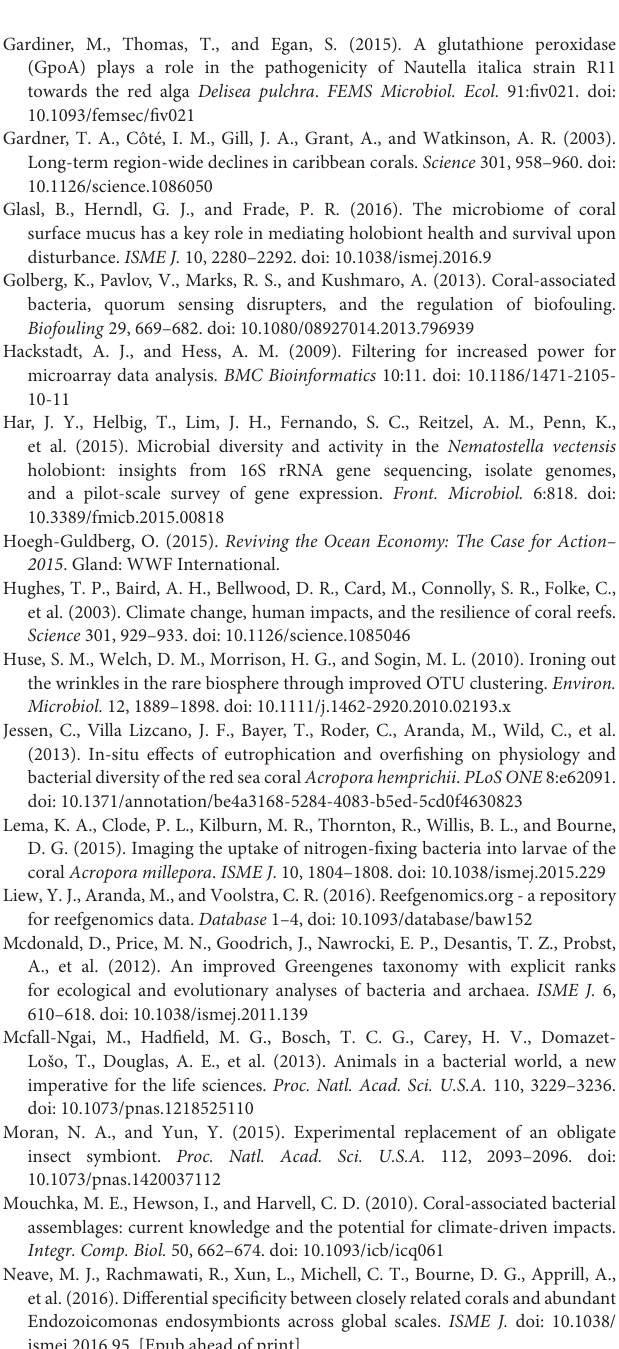
closest BLASTn match for the reference OTU sequence including source environment and available literature is denoted. Supplementary Data Sheet 3 | Non-metric multidimensional scaling (nMDS) plot of bacterial communities of aposymbiotic and symbiotic Aiptasia and water samples. Clustering of samples based on Yue & Clayton theta similarity coefficient of microbial community abundances ( R 2 = 0.95, lowest stress = 0.108). Supplementary Data Sheet 4 | Taxonomy-based functional profiling of bacterial communities on average bacterial community composition of